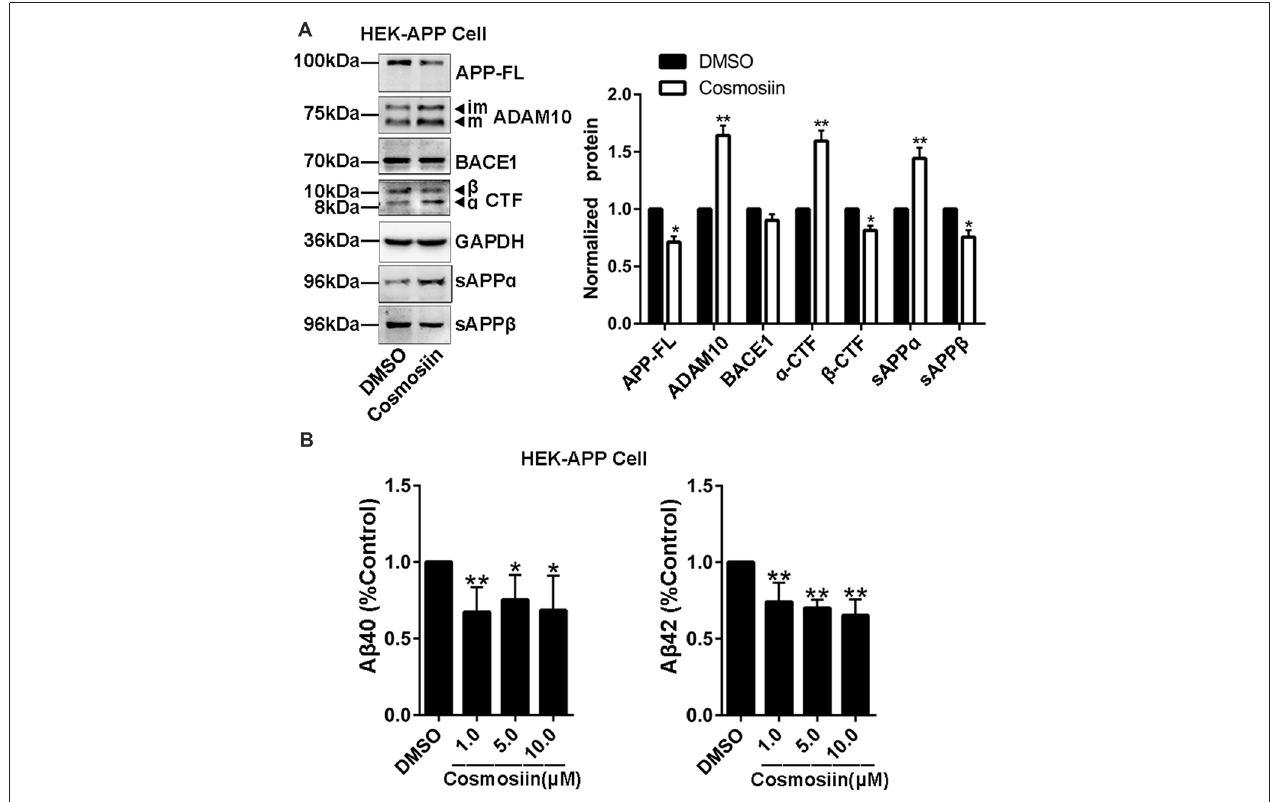
FIGURE 5 | Cosmosiin affects amyloid precursor protein (APP) processing and A β production. (A) Representative Western blots (left) and bar plot summary (right) of full-length APP (APP-FL), ADAM10, BACE1, α -/ β -CTF, sAPP α and sAPP β levels in HEK-APP cells treated with the vehicle DMSO (1:10,000) or 5 µ M cosmosiin for 36 h. (B) Normalized levels of A β 1–40 (left) and A β 1–42 (right) measured by enzyme-linked immunosorbent assay (ELISA) in the culture medium of HEK-APP cells treated with the vehicle DMSO (1:10,000) or cosmosiin (1, 5 and 10 µ M) for 36 h. Data are expressed as means ± SD. ∗ P < 0.05; ∗∗ P < 0.01 ( n =